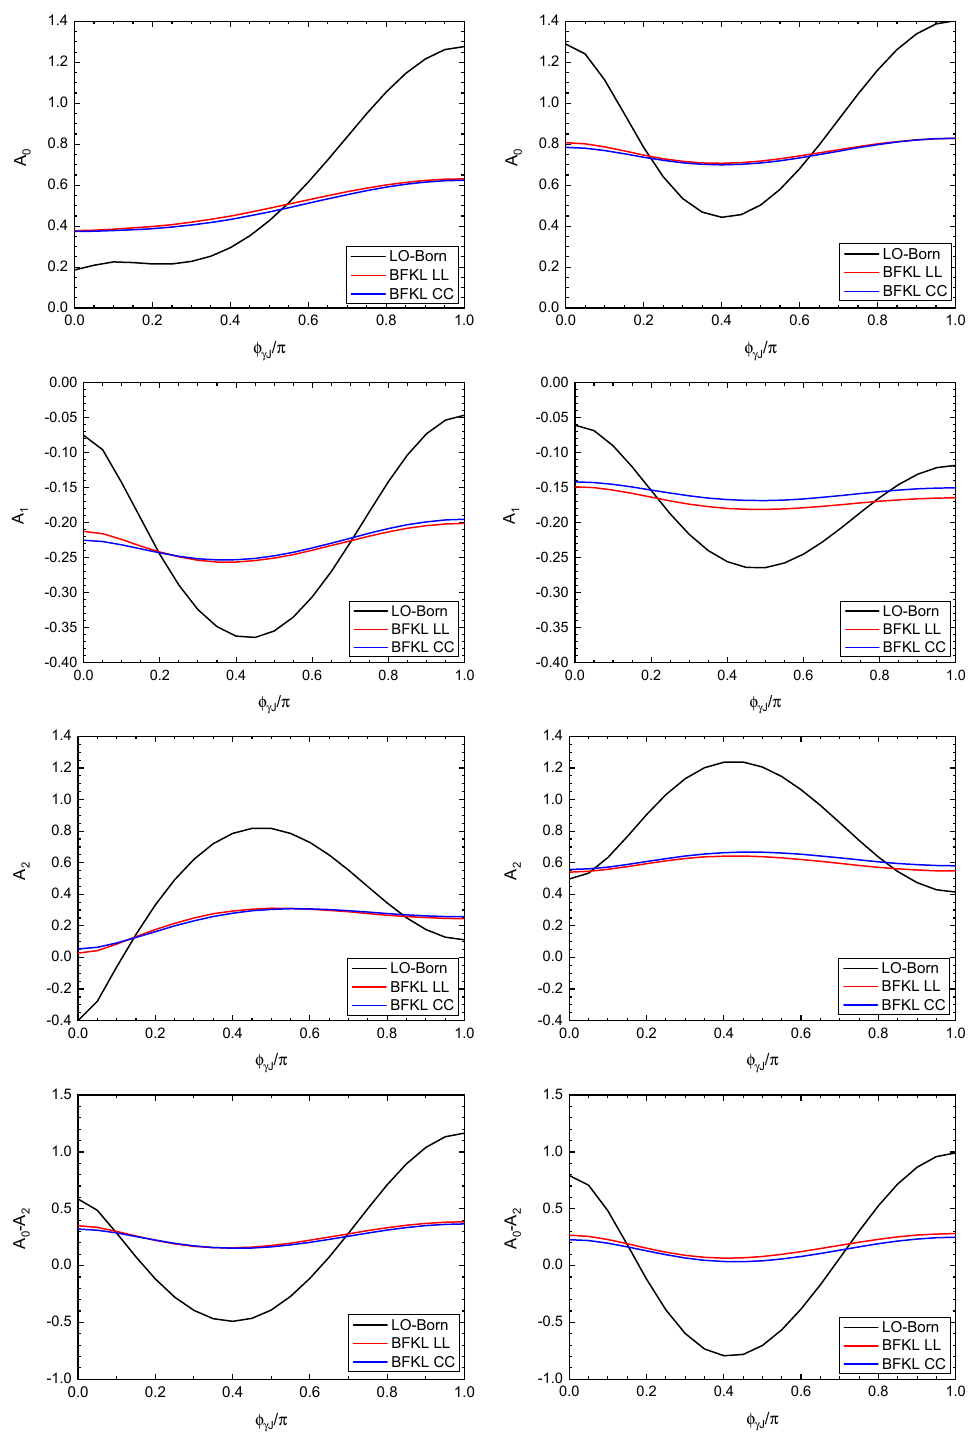
Figure 6 . The angular coe(cid:14)cients A 0 ; A 1 and A 2 as functions of the photon-jet angle (cid:30) (cid:13)J for the three indicated approximations together with the Lam-Tung di(cid:11)erence A 0 (cid:0) A 2 . The photon transverse momentum q ? = 25 GeV (left column) and q ? = 60 GeV (right column) while the other parameters: p J ? = 30 GeV, (cid:1) Y (cid:13)J = 7 and M = 35 GeV.